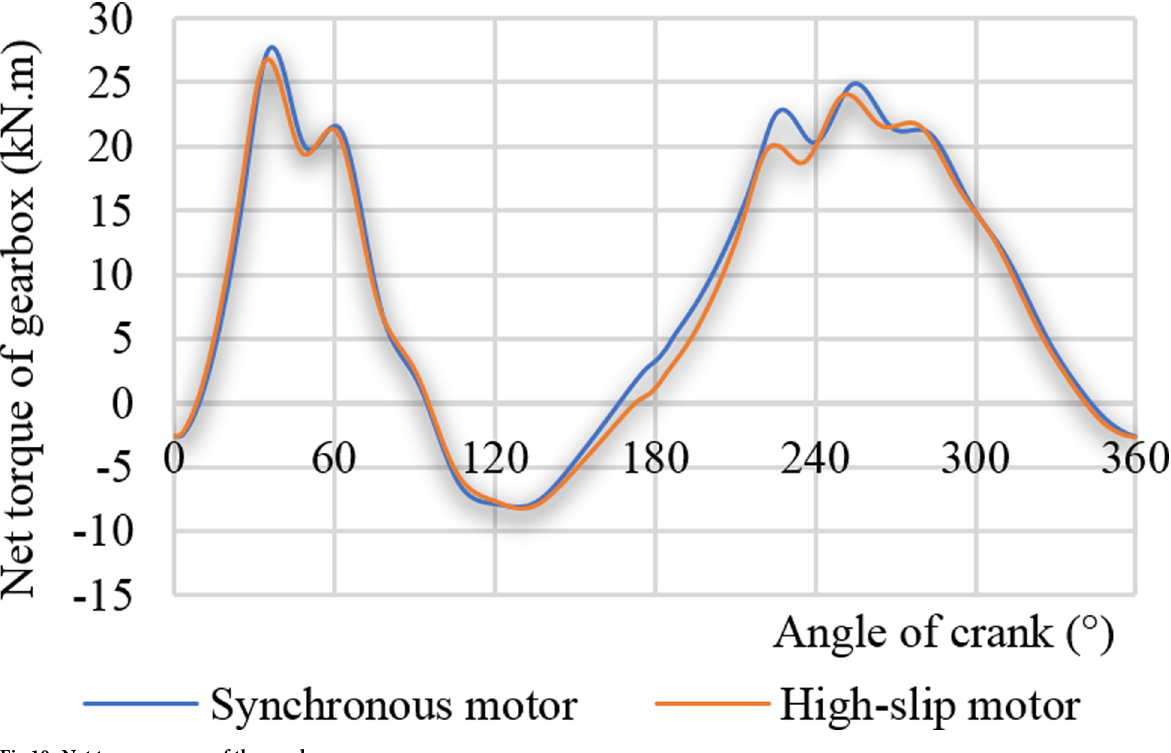
Fig 10. Net torque curves of the